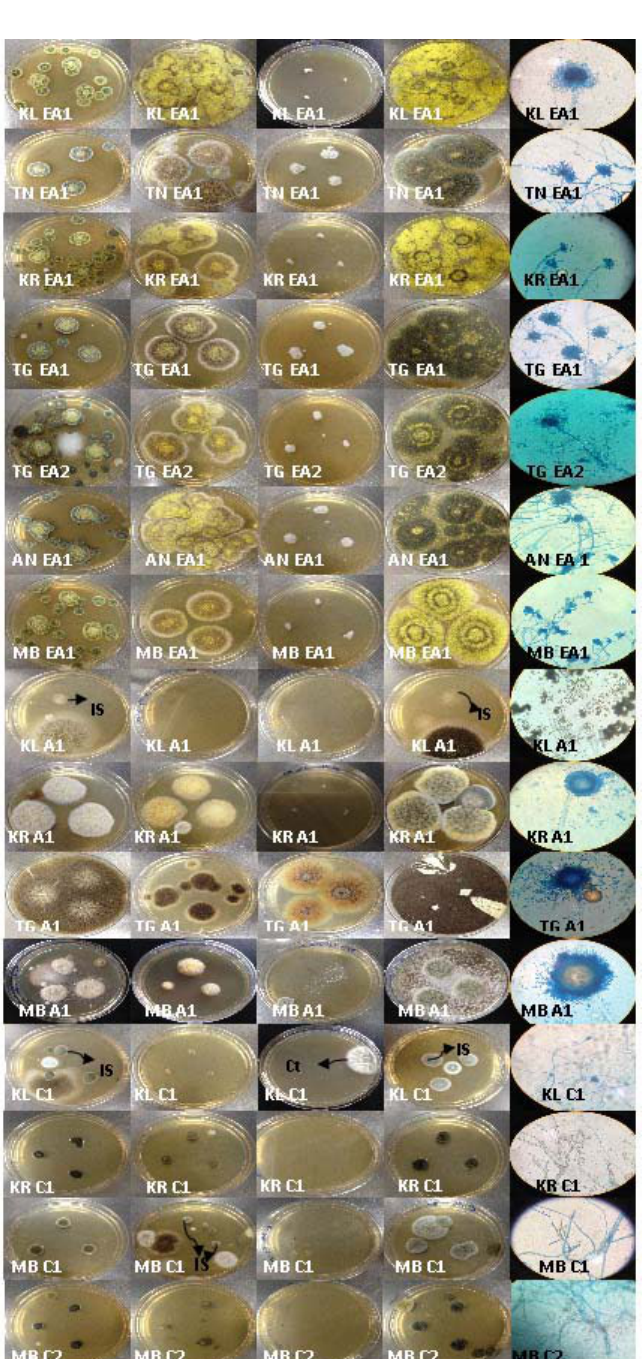
Fig. 3. Isolates of Eurotium amstelodami , Cladosporium sp., and Aspergillus sp., grown on CYA 25°C, G25N 25°C, CYA 37°C, CY20S 25°C and microscopic